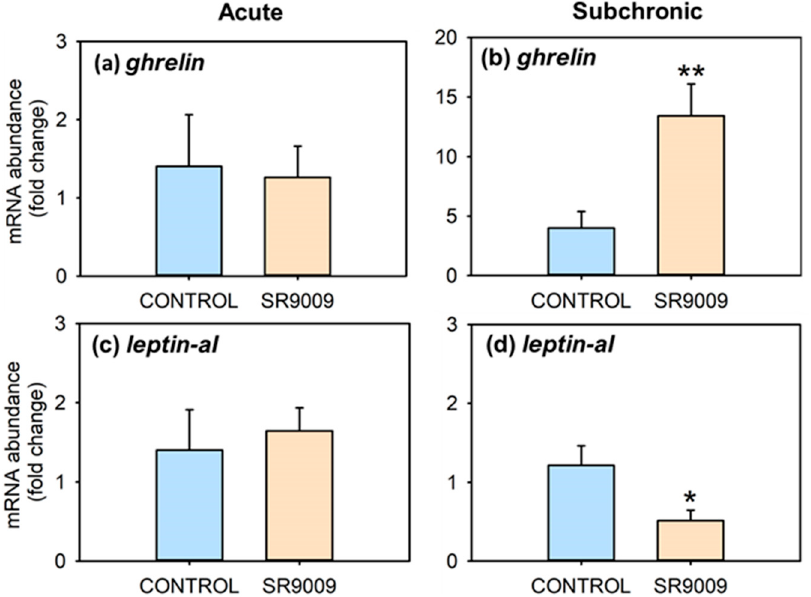
Figure 4. Effect of acute and subchronic SR9009 treatment on peripheral feeding regulators. Relative mRNA abundance of ghrelin ( a , b ) and leptin-aI ( c , d ) in the intestine and liver, respectively, of goldfish ( Carassius auratus ) treated with vehicle alone (CONTROL) or containing SR9009 (100 µ g/g bw). The left column shows results of the acute treatment ( n = 9 fish/group), and the right column of the 7-day subchronic treatment ( n = 12 fish/group). Data are expressed as mean + S.E.M. in relative units (2 − ∆∆ Ct ). * p < 0.05, ** p < 0.01 SR9009 compared to control group (Student’s t -test).